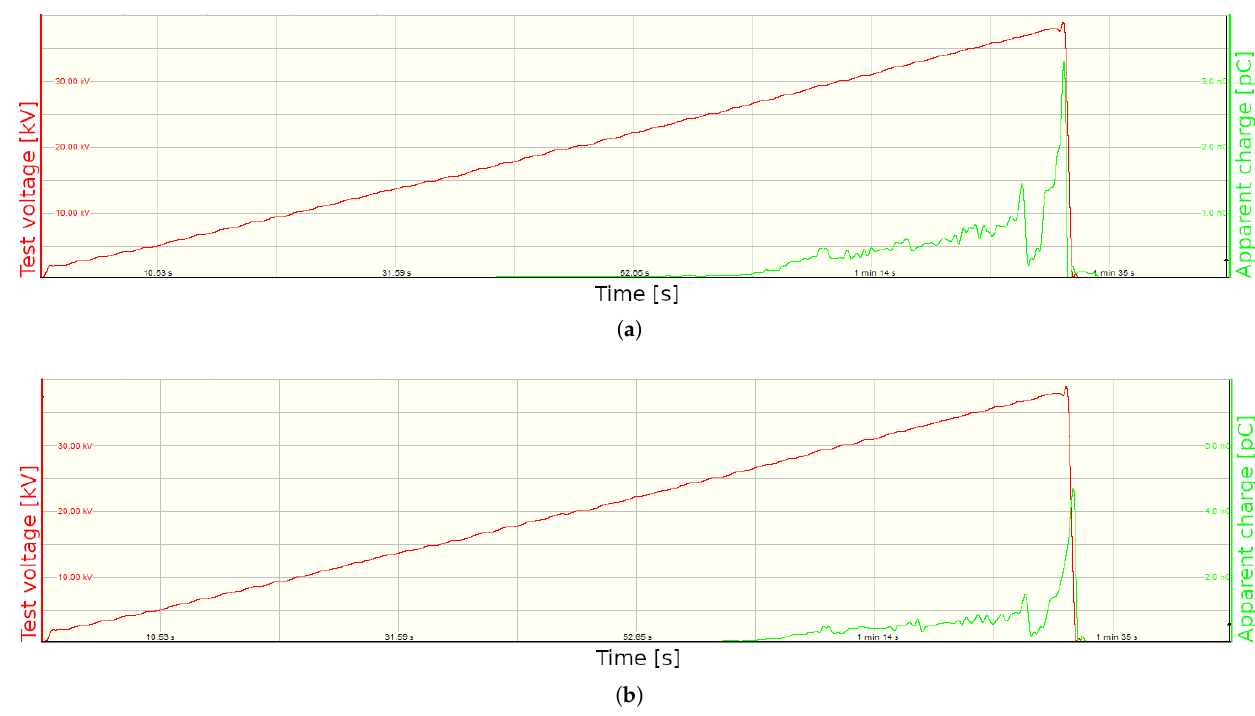
Figure 13. Waveforms of the Q ( U p ) dependence for the voltage ramp without corona rings: ( a ) ME method, ( b ) HF